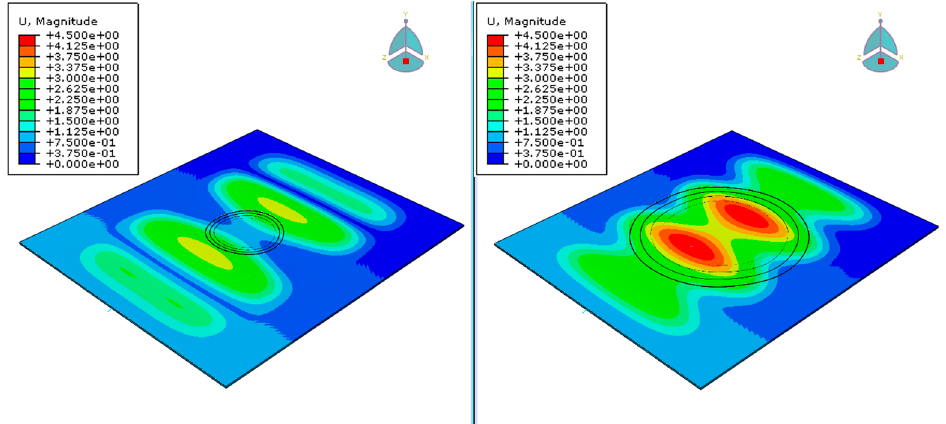
Figure 6. Deformed body (U, Magnitude) for repair with 20 repair ratio ( left ) and 50 repair ratio ( right ).